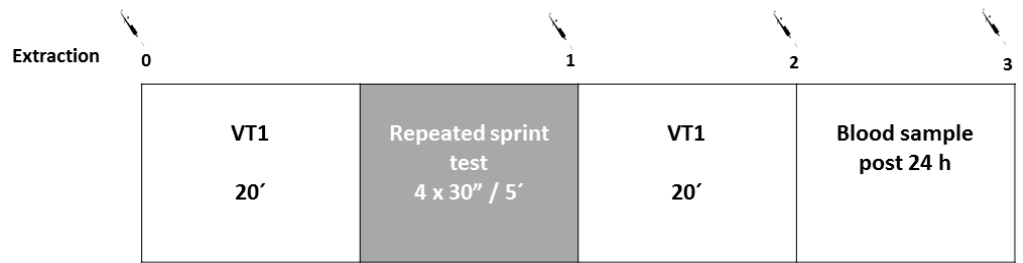
Figure 2. Exercise protocol and blood sampling plan during Visit 3 / 6. VT1 = ventilatory threshold 1; syringe = blood sample. 214